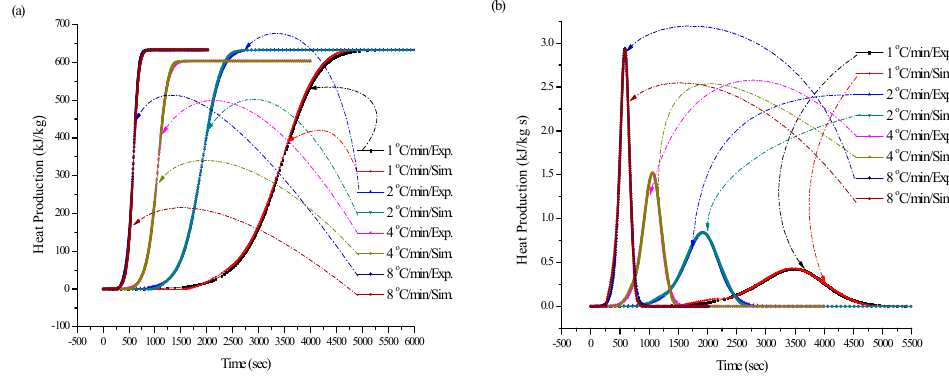
Figure 8. ( a ) Heat production versus time and ( b ) heat production rate versus time of model fitting with non-isothermal DSC at heating rates of 1, 2, 4, and 8 °C/min for ADVN with 24 h UV via experiments and simulations. Table 2. Reaction kinetic simulation for ADVN with UV/24 h using non-linear regression methods at heating rates of 1, 2, 4, and 8 ◦